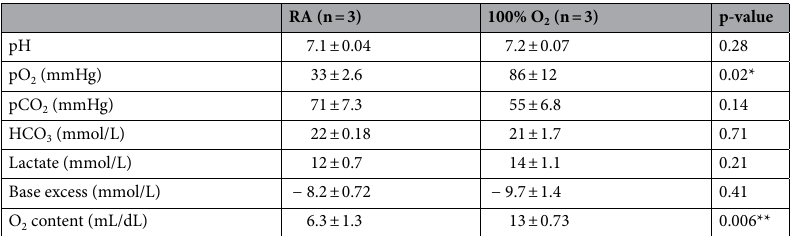
Table 2. Blood gas analysis of the pups after in utero exposure to maternal hyperoxia. Left ventricular blood from three pups/unique dam/treatment condition was pooled prior to blood gas analysis, with the dam considered as the experimental unit. * p ≤ 0.05; ** p ≤ 0.01